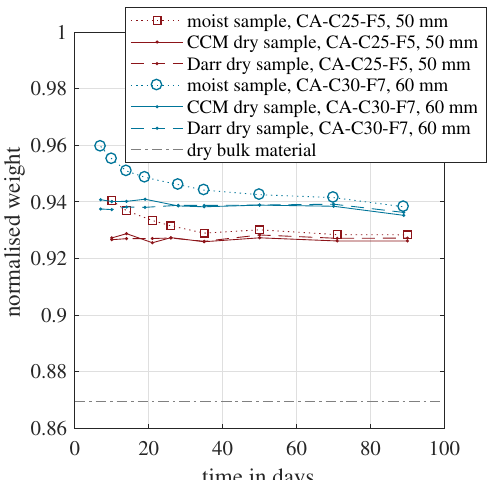
Figure 6. Evolution of the normalised dry weight over time measured for two samples with a calcium sulphate based